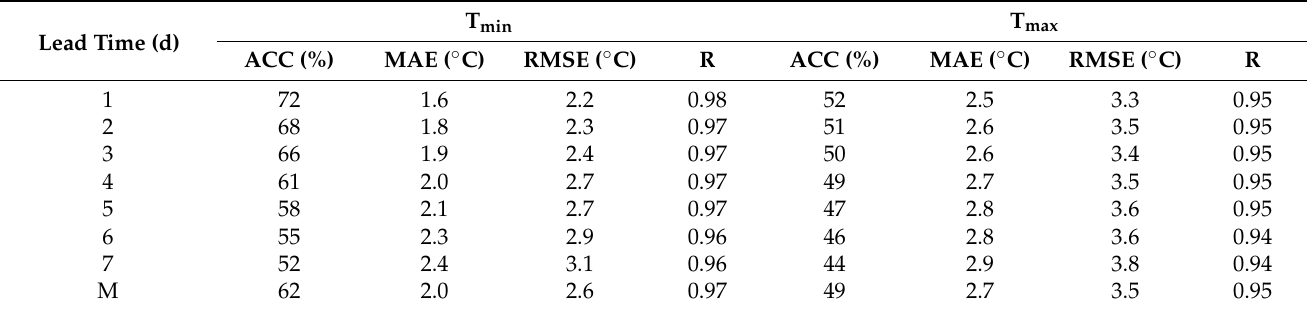
Table 3. Average values of statistical indicators for temperature